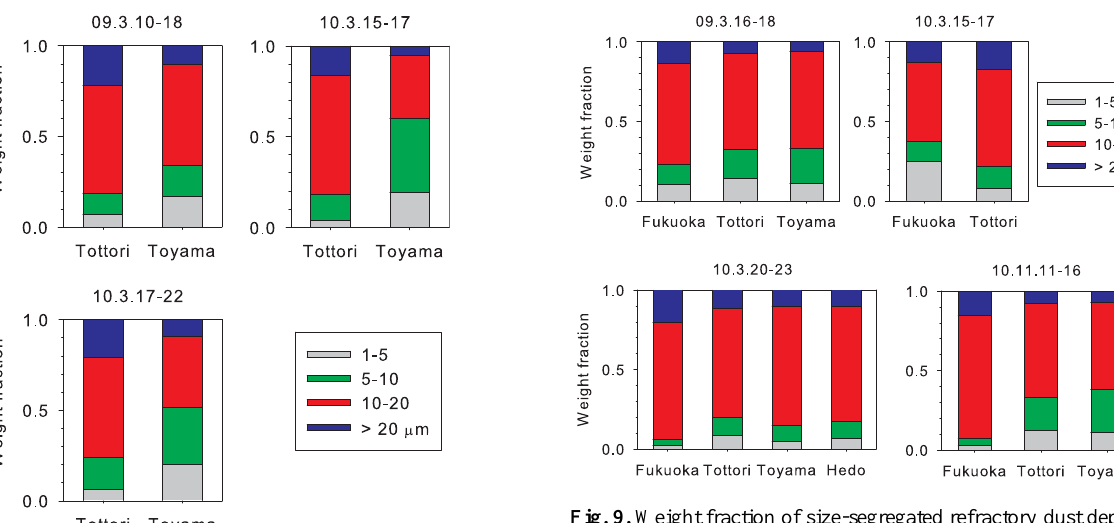
Fig. 9. Weight fraction of size-segregated refractory dust deposited by dry processes Sampling periods are shown at the top of each panel as